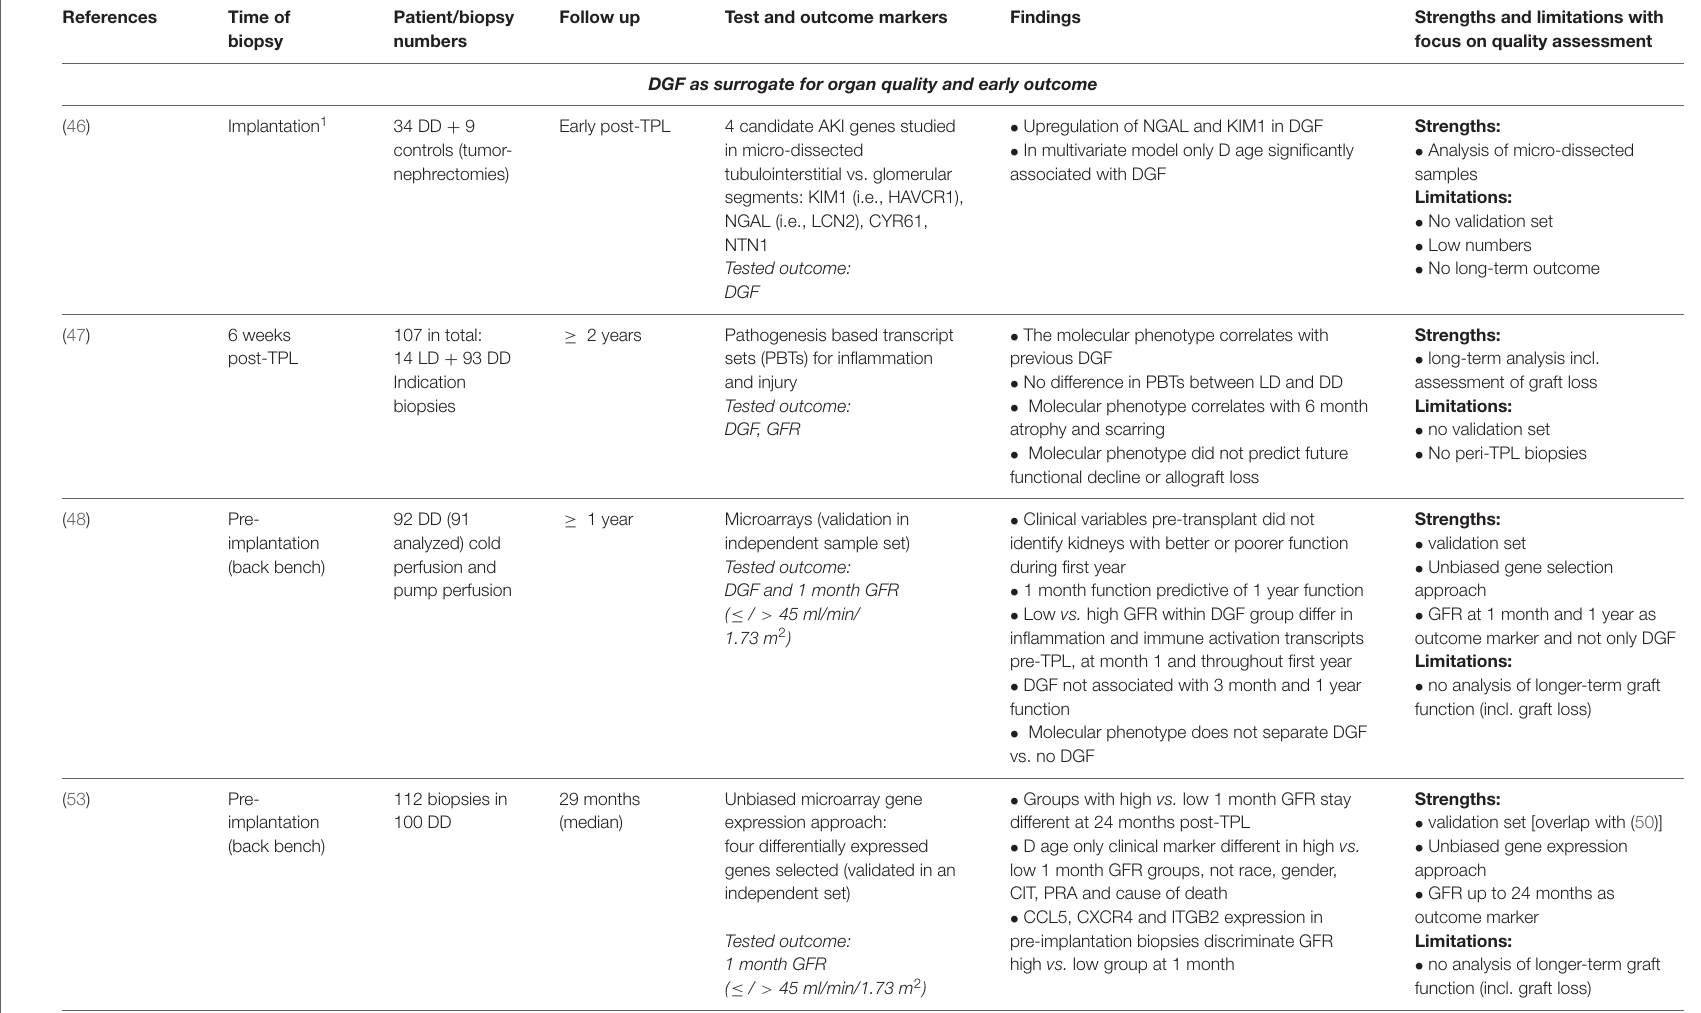
TABLE 2 | Molecular diagnostics of early kidney transplant biopsies [summarizing studies published since 2011, studies published before were previously summarized